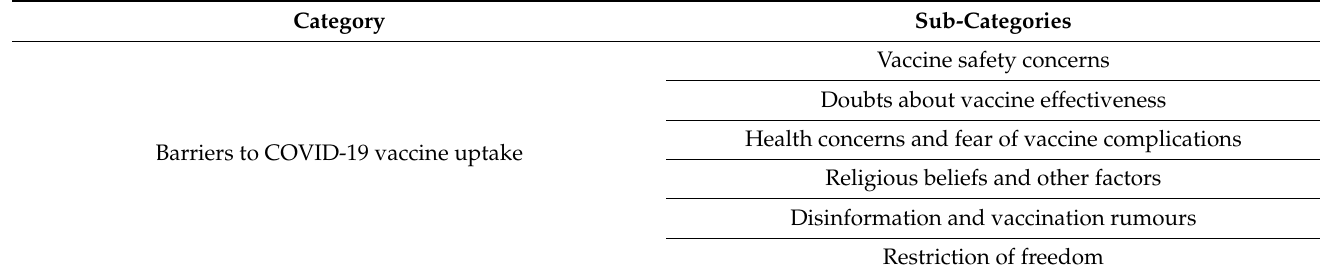
Table 2. Barriers to COVID-19 vaccine